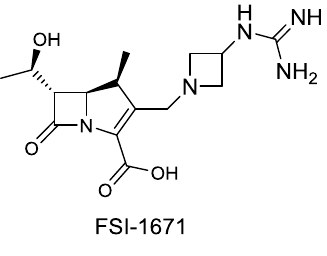
Figure 22. Chemical structure of